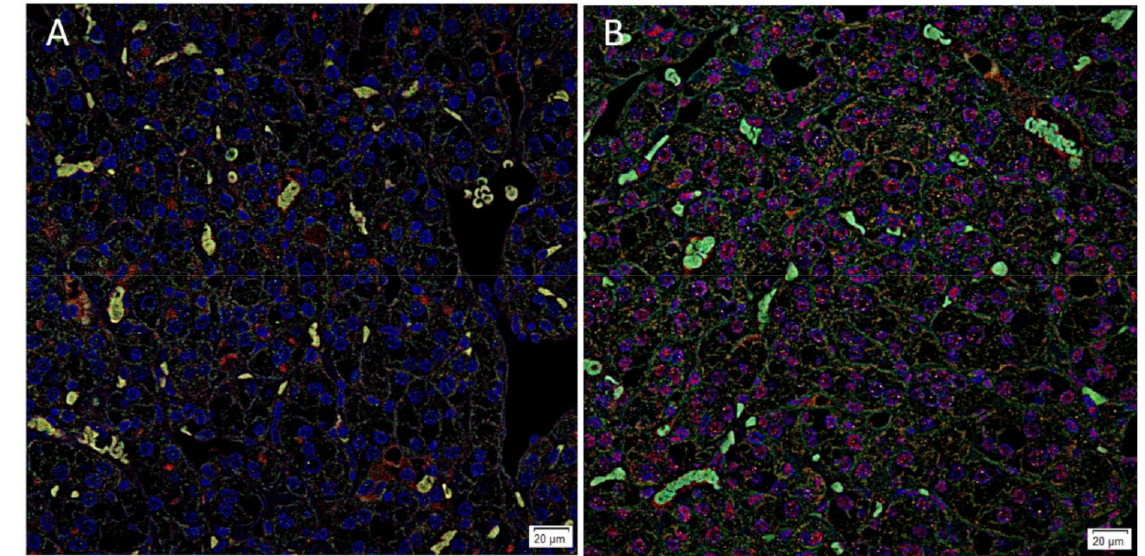
Figure 3. Representative immunofluorescence-stained sections of renal clear cell carcinoma tissue stained for of AT 2 R ( A , red) with OCT4 ( A , green). AT 2 R ( B , red) was detected on the OCT4+ ( B , green) CSCs. Cell nuclei were counterstained with 4 (cid:48) ,6-diamidino-2-phenylindole ( A , B , blue). Original magnification 400 × . Scale bar: 20 µ